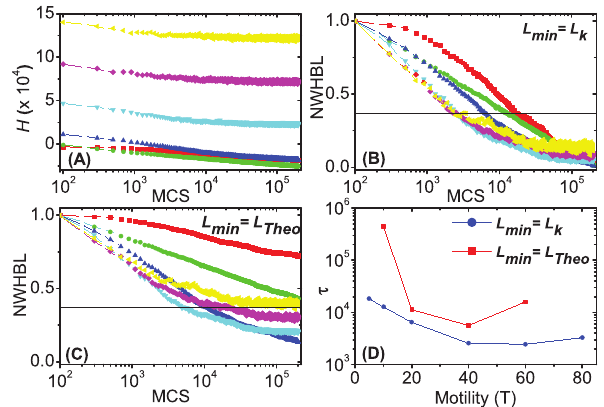
Figure 7. Evolution of the effective energies (H) and normal- ized weighted heterotypic boundary lengths (NWHBL) for aggregates with 5 cadherin levels and the same maximum to N minimum expression range [1, 23] using the THBM with – 10; m – 20; . – 40; % – 60; b – different motilities. & – 5; 80. ( A ) Evolution of H . In ( B ) and ( C ) the time at which the heterotypic boundary length of a given simulation crosses the horizontal black line N is defined as its relaxation time t . In ( B ) L min ~ L k and in ( C ) L min ~ L theo . – ( D ) Relaxation time vs. relative cell motilities. & – L min ~ L theo ; L min ~ L k . The error bars in the graphs are calculated from ten simulation